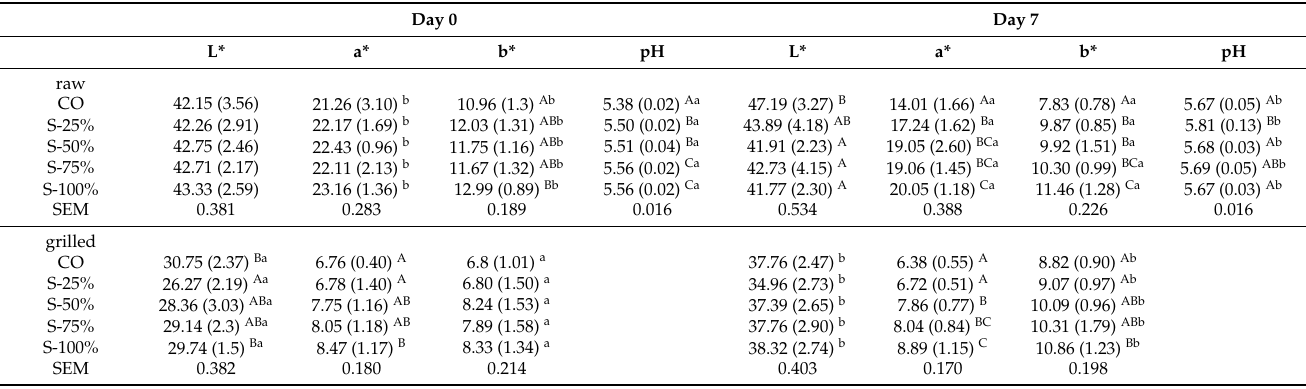
Table 1. Effect of the fat substitute used (freeze-dried hydrogel emulsion with encapsulated açai oil) on the color parameter (L*, a*, b*) and pH at 0 and 7 days of storage for both raw and grilled burgers. Day 0 Day